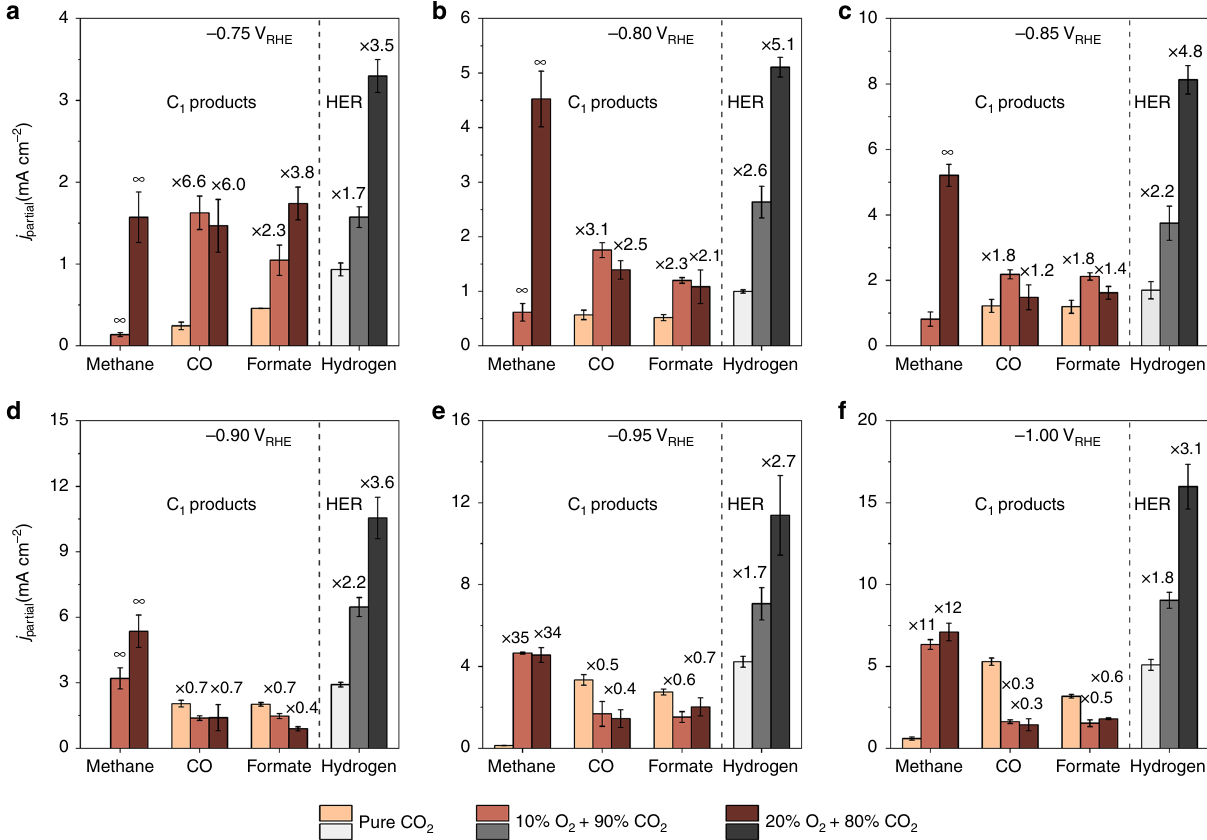
Fig. 2 Comparison of C 1 product and H 2 formations. The partial current densities of C 1 products and H 2 measured at 100% CO 2 , 10% O 2 + 90% CO 2 , and 20% O 2 + 80% CO 2 are compared at different potentials of a − 0.75 V RHE , b − 0.80 V RHE , c − 0.85 V RHE , d − 0.90 V RHE , e − 0.95 V RHE , and f − 1.0 V RHE . The numbers stand for the enhancement relative to the rates at pure CO 2 . The error bars represent the standard deviation from at least three independent